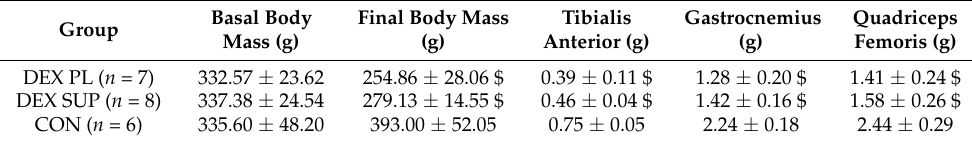
Table 3. Body and skeletal muscles mass at the end of the experiment in DEX-treated rats. Basal Body Final Body Tibialis Ante- Gastrocnem- Quadriceps Group Mass (g) Mass (g) rior (g) ius (g]) Femoris (g) DEX PL ( n = 7) 332.57 ± 23.62 254.86 ± 28.06